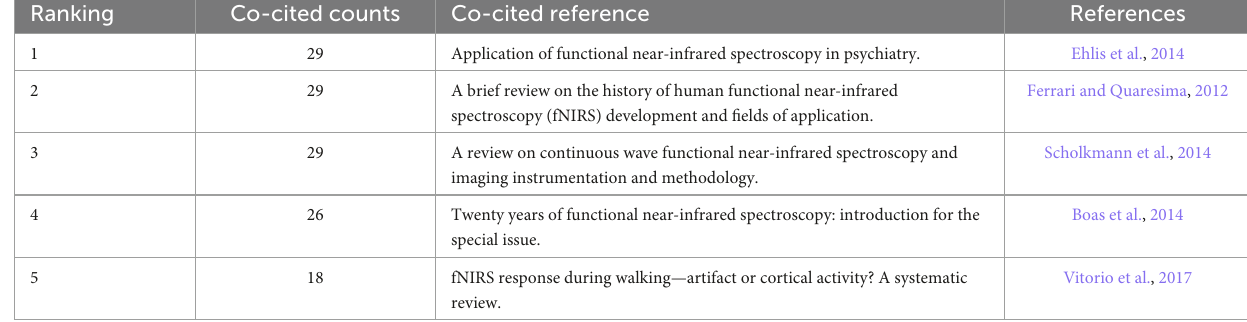
TABLE 5 Top five cited references related to functional near-infrared spectroscopy (fNIRS) research on